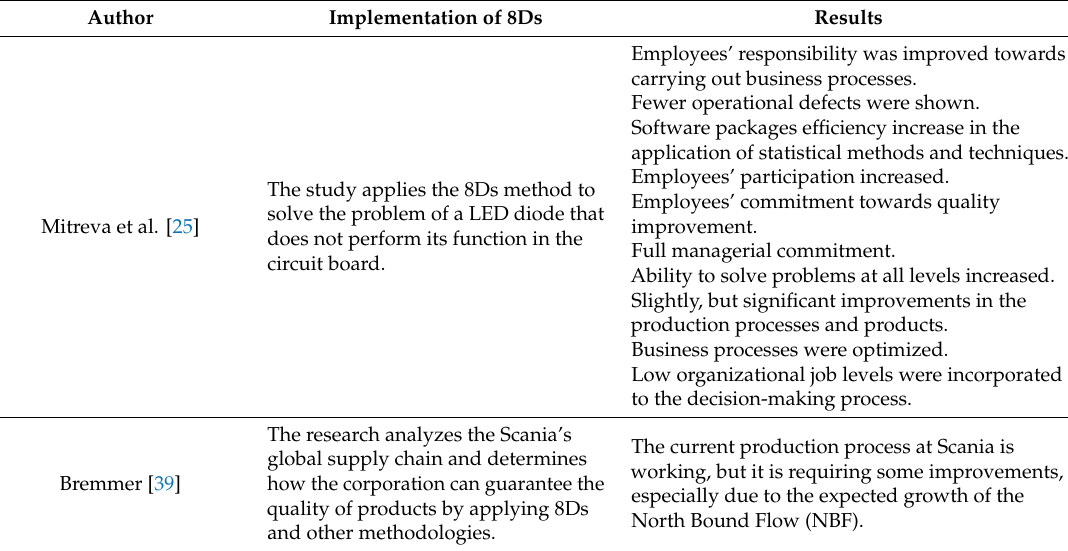
Table 1. Recent case studies applying the 8Ds